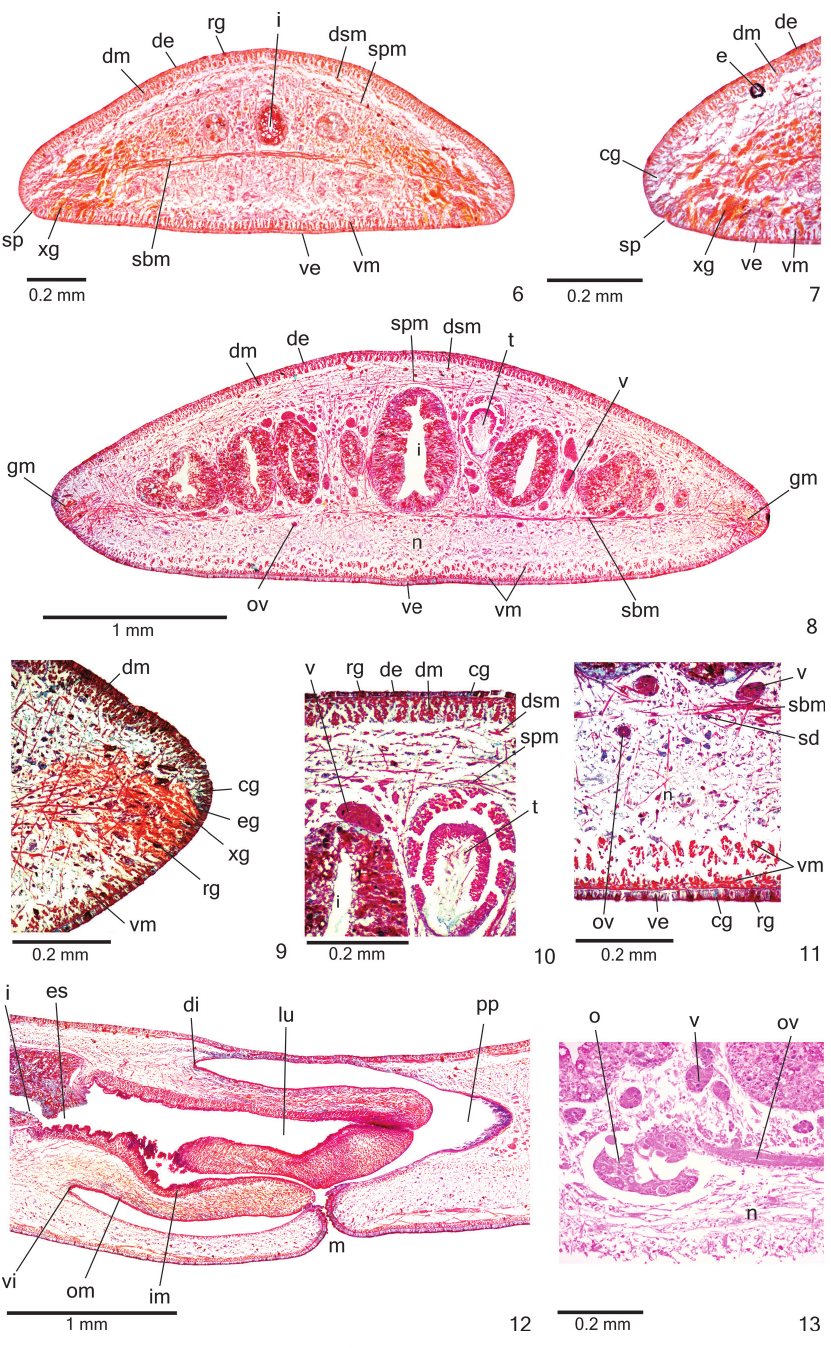
Figures 6–13. Cratera cryptolineata sp. n., holotype, 6–7 anterior region, transverse section 8–11 pre- pharyngeal region, transverse sections: body margin ( 9 ), dorsal portion ( 10 ), ventral portion ( 11 ) 12 pharynx, sagittal section 13 ovary, sagittal